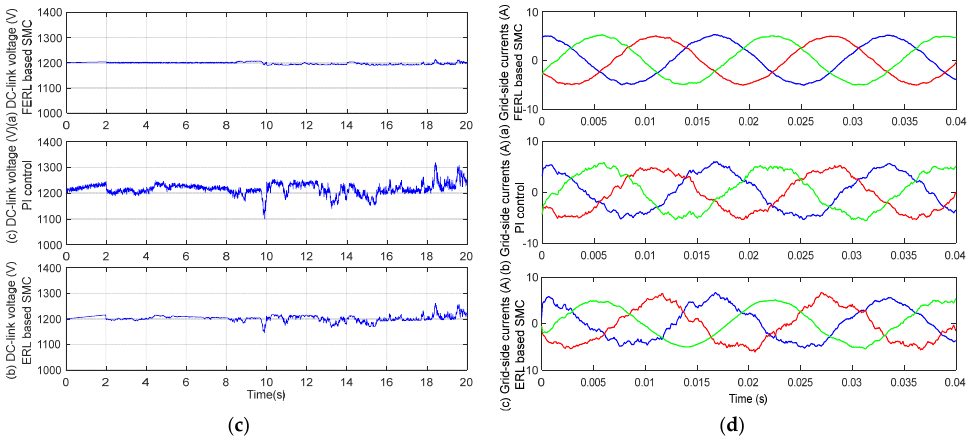
Figure 14. Experimental results under variable wind speed comparing three different approaches: ( a ) generator speed ( b ) active power tracking; ( c ) DC ‐ link voltage; ( d ) grid ‐ side currents.